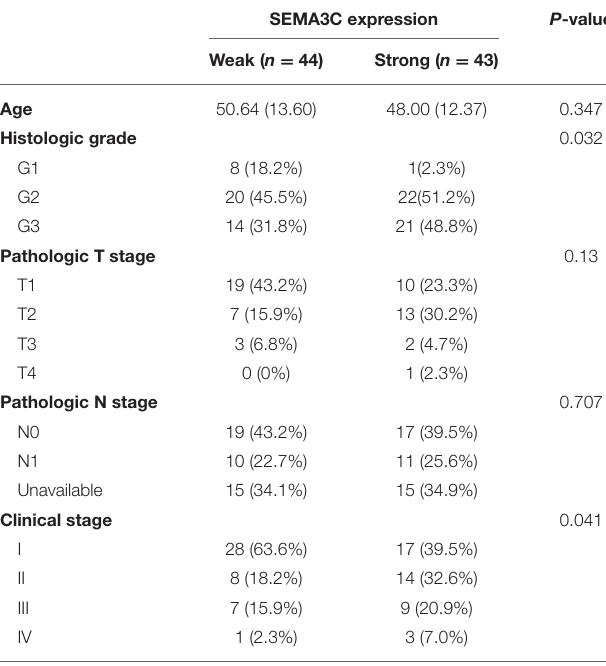
TABLE 1 | The correlation between SEMA3C expression and clinic pathological features in our cohort.